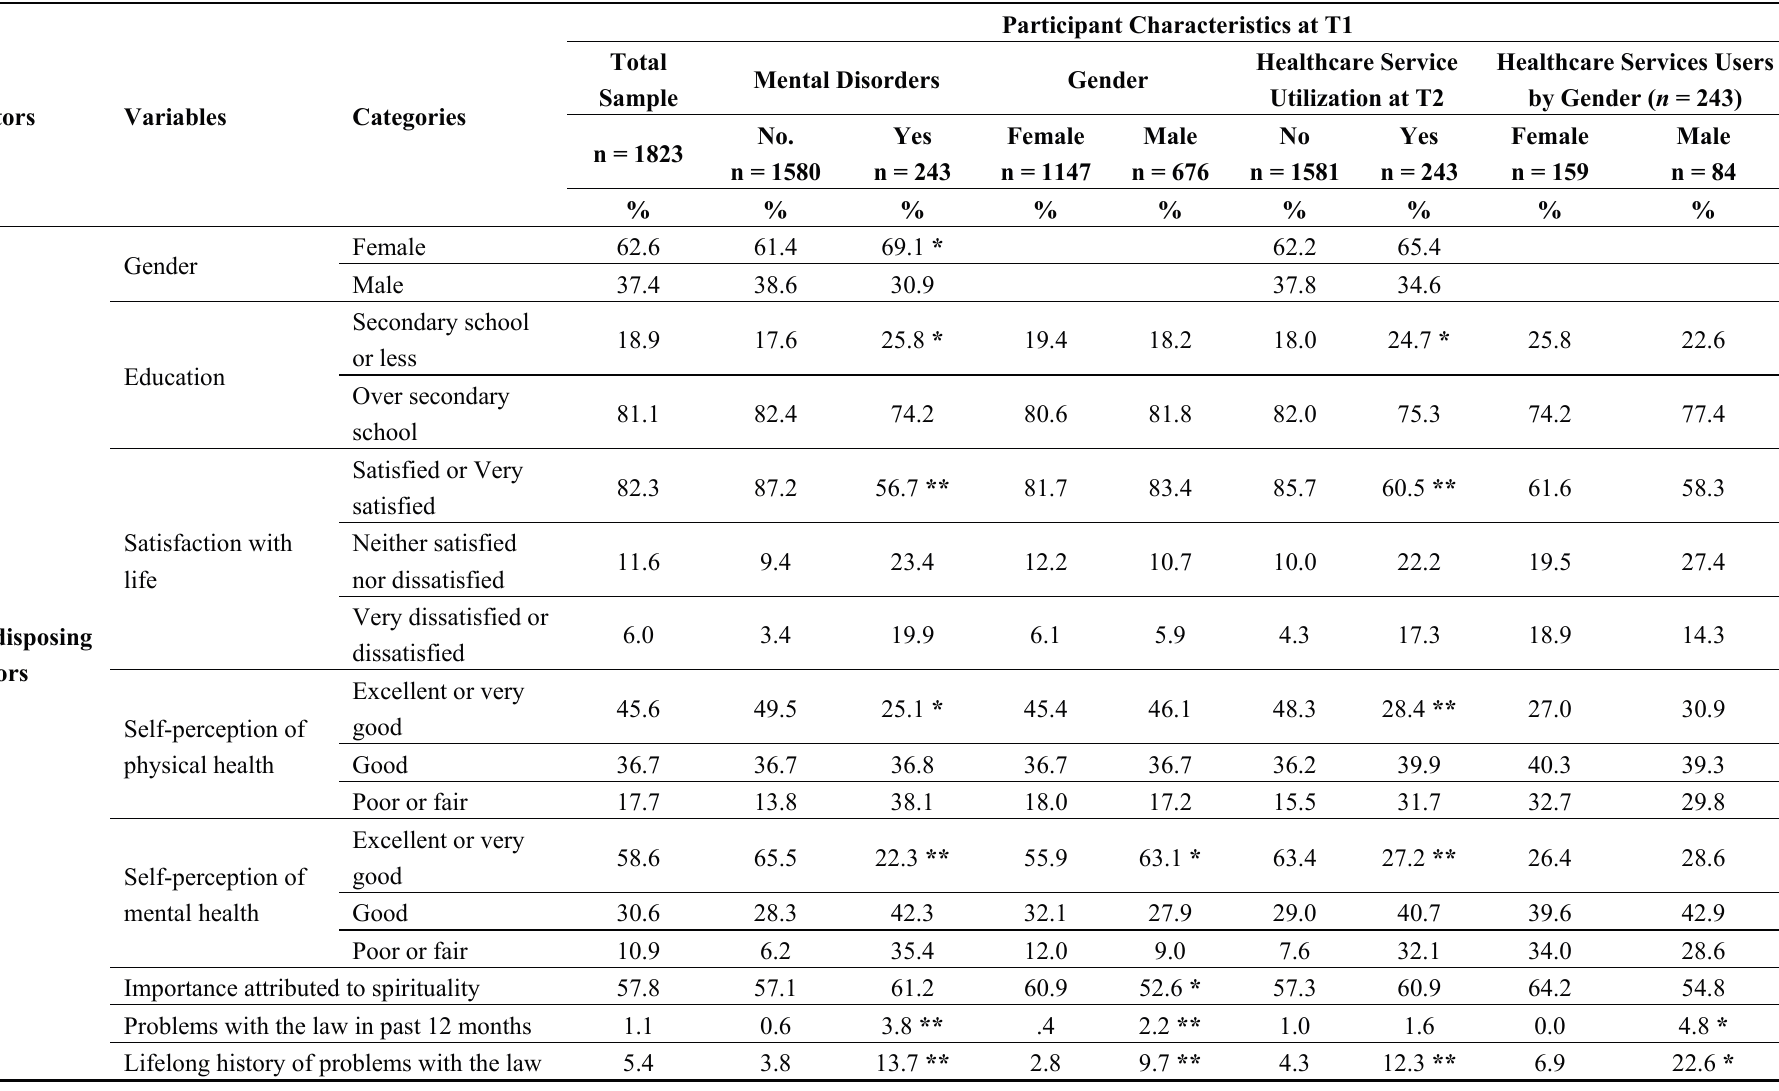
Table 2. Participant characteristics by mental health status, gender and healthcare service utilization: categorical variables.